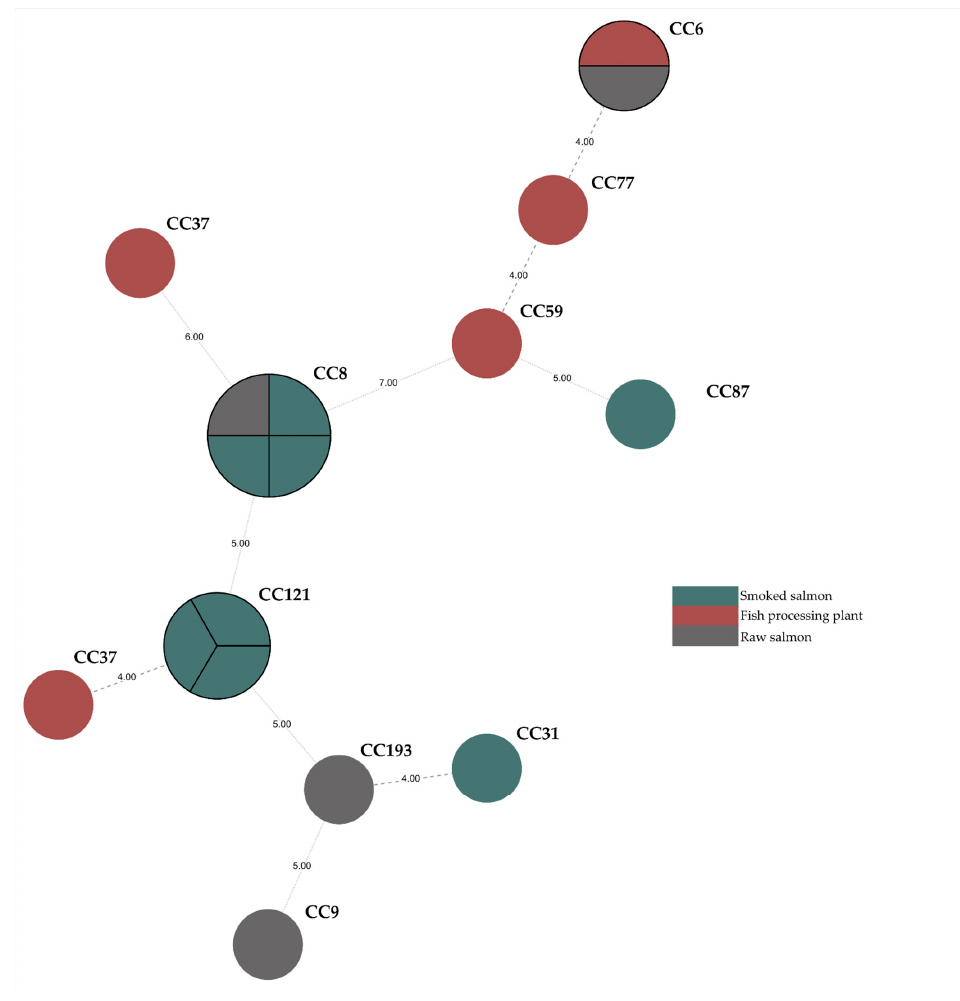
Figure 2. Minimum spanning tree analysis based on the MLST allelic profiles of 17 L. monocytogenes isolates. Each circle represents a sequence type (ST). The numbers on the connecting lines illustrate the numbers of target genes with different alleles. The sources of isolates are distinguished by the colors. Only four genes ( inlA , inlE , inlH, and inlC2 ) from the internalin gene family members were found in all isolates tested, whereas the inlB , inlC , inlJ , inlK, and inlD genes were present on 94.12% of isolates. Moreover, the analysis showed that three of the tested iso- lates (17,65%) harbored a premature stop codon (PMSC). Isolates with inlA gene trunca- tion belonged to serogroup IIa, ST121, ST193, and ST31 (Figure 3).